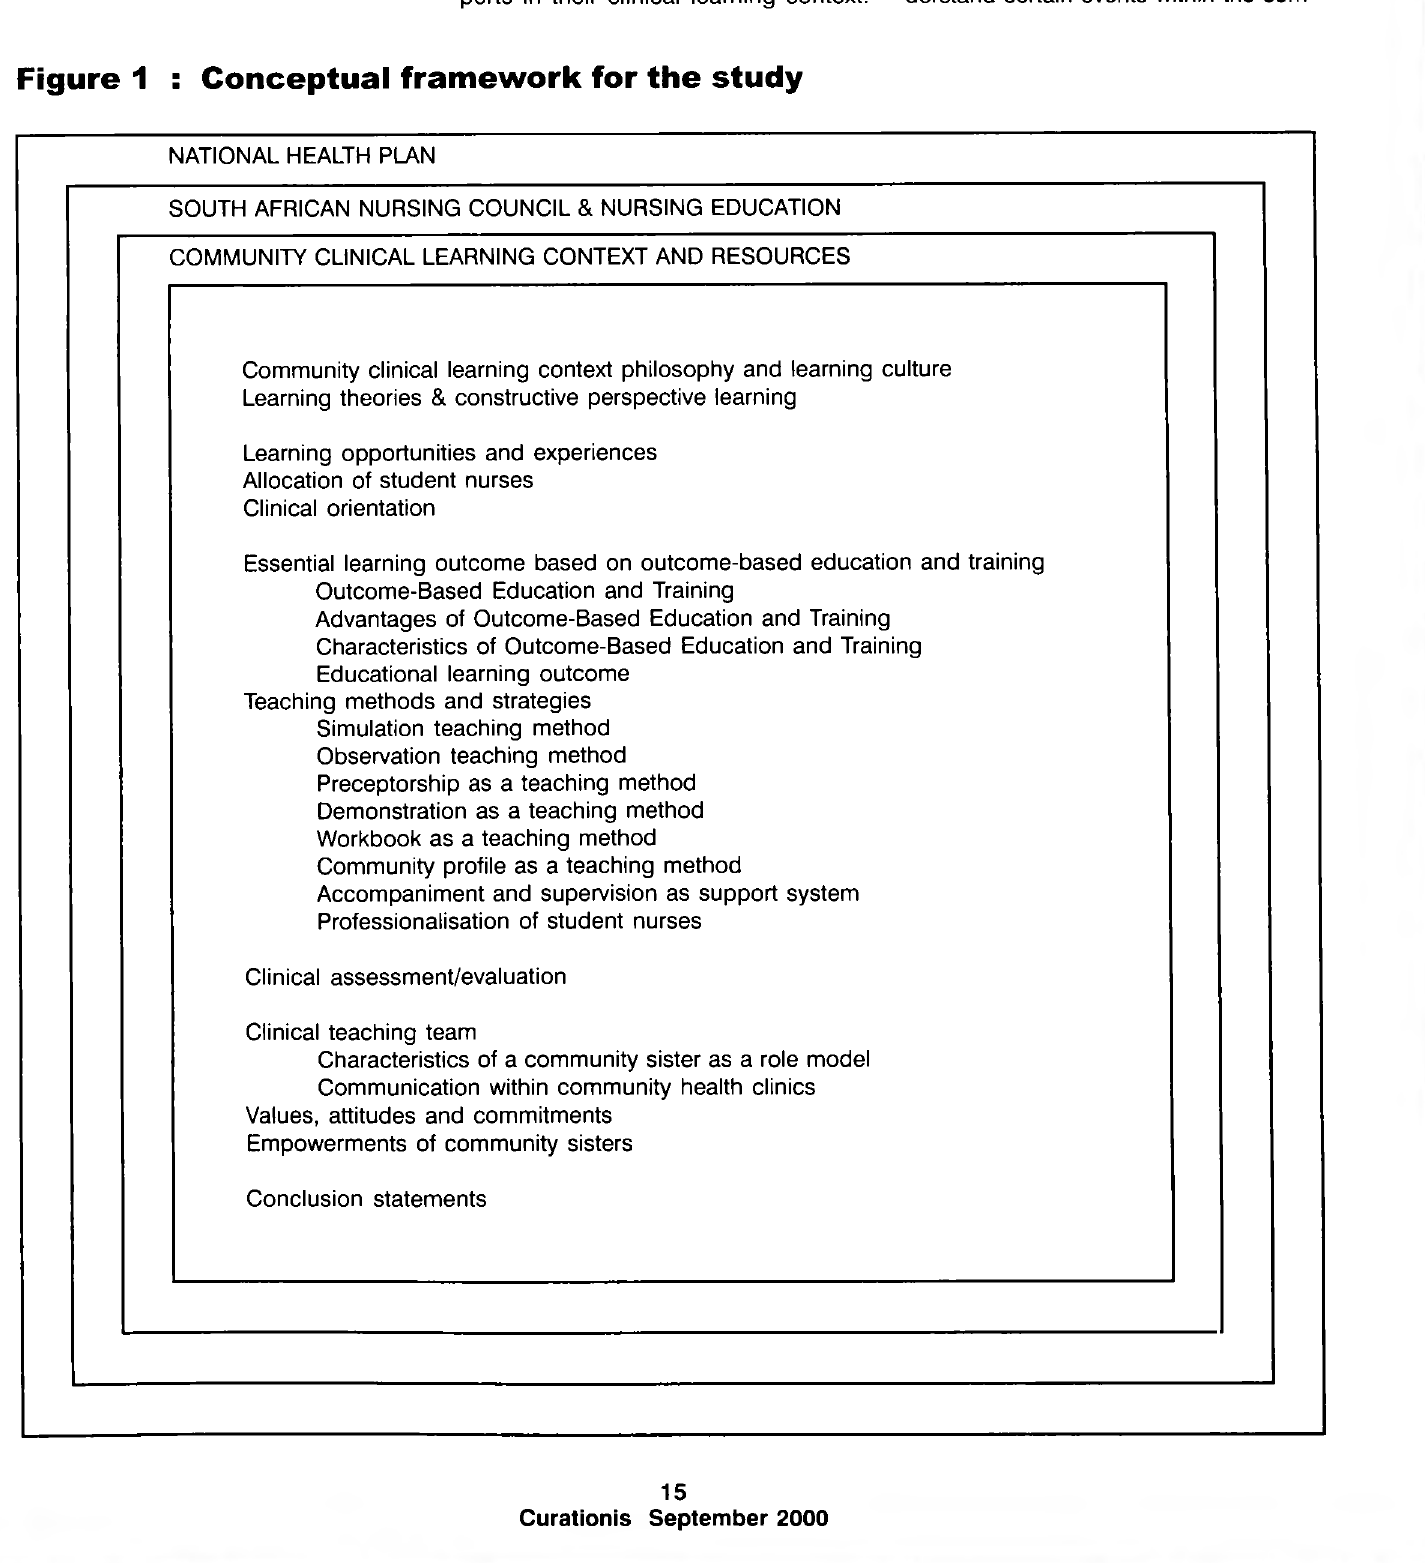
Figure 1 : C onceptual fra m e w o rk for th e